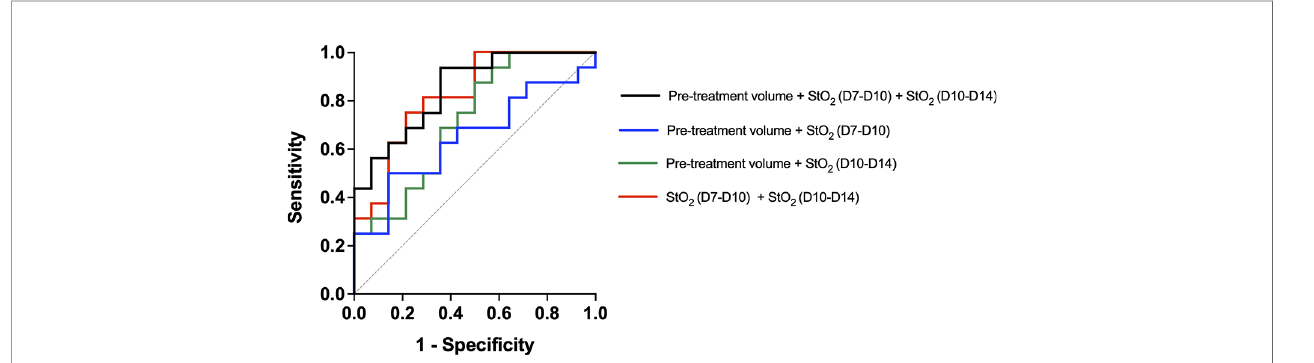
FIGURE 9 | Receiver operating characteristic curve showcasing the predictive capability of various parameters used in the multiple logistic regression analysis. The model created with Pretreatment volume and change in StO 2 between D7 – D10 and D10 – D14 had the highest AUC. The line of identity is shown as a gray dotted line.